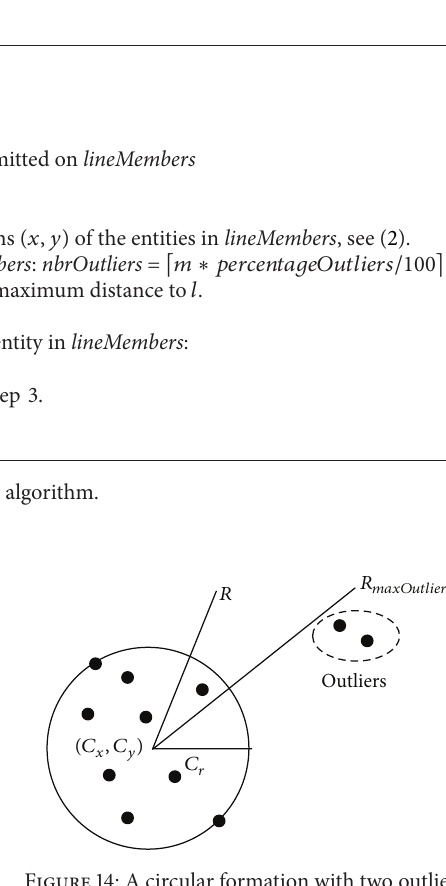
Figure 14: A circular formation with two